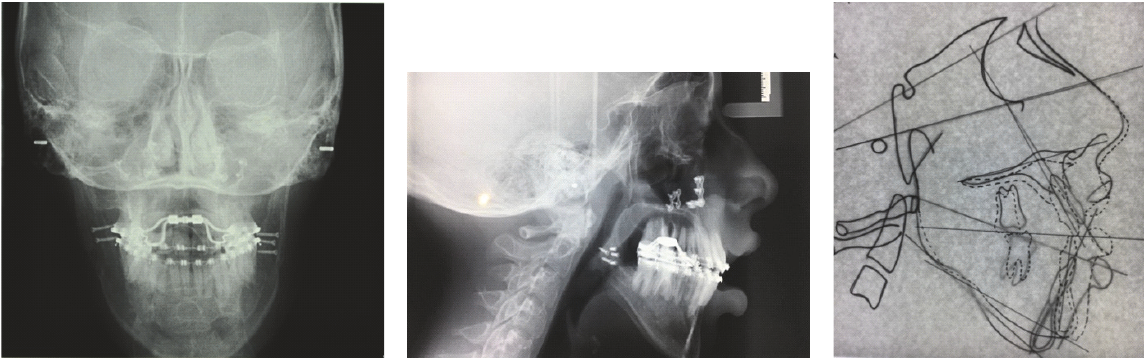
Figure 7: Rx after surgery.